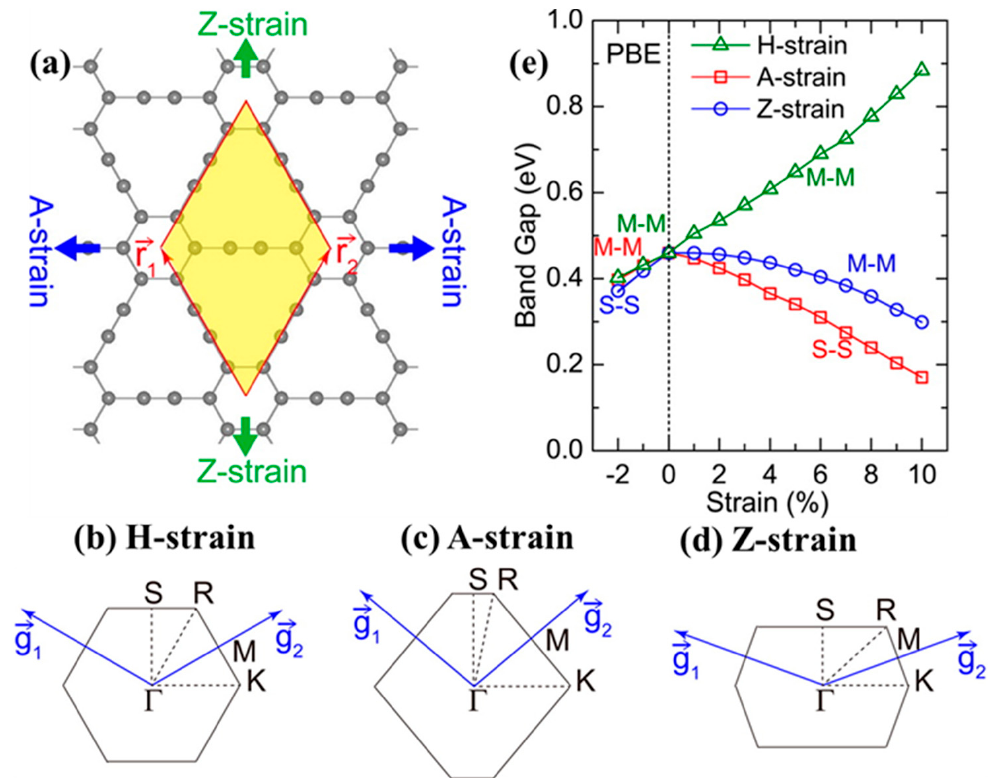
Figure 13. The structure of GY film. The yellow parallelogram indicates the unit cell ( a ). Brillouin zone with high-symmetry points marked beneath H-strain ( b ), A-strain ( c ), and Z-strain ( d ). The band gap shift under different applied strains determined from GGA-PBE ( e ). Reproduced with permission [127]. Copyright 2013, American Chemical